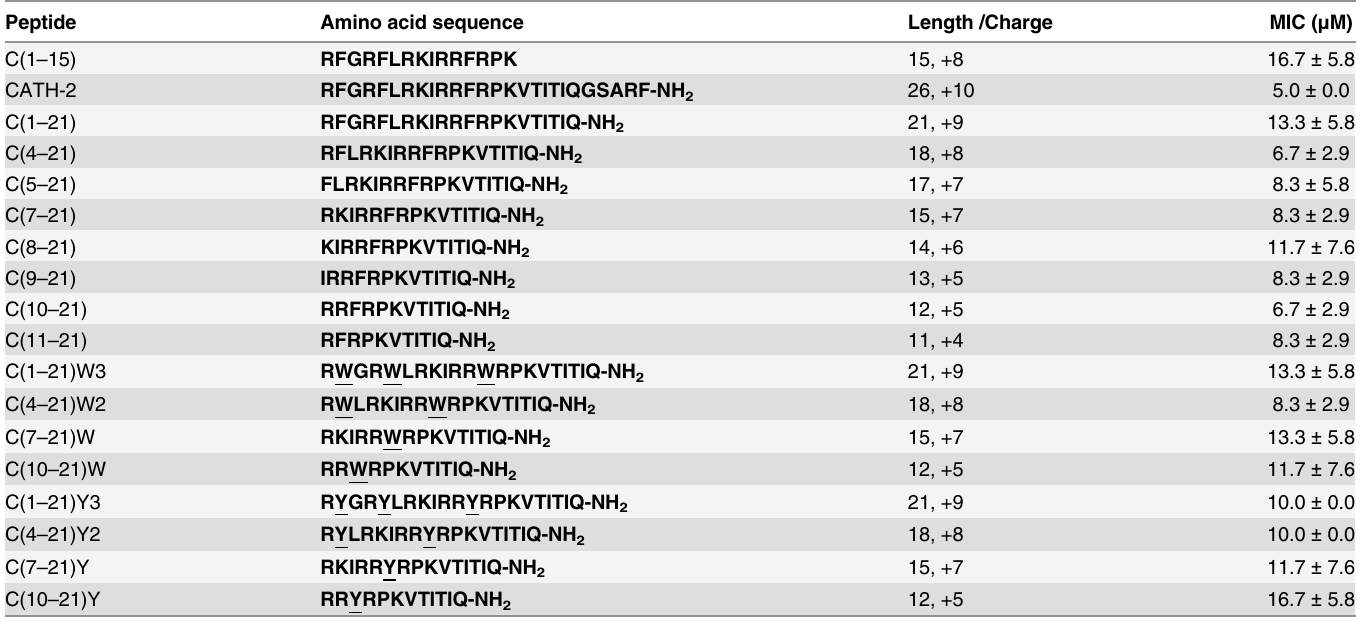
Table 1. Amino acid sequences and minimal inhibitory concentrations of CATH-2 analogs. Peptide Amino acid